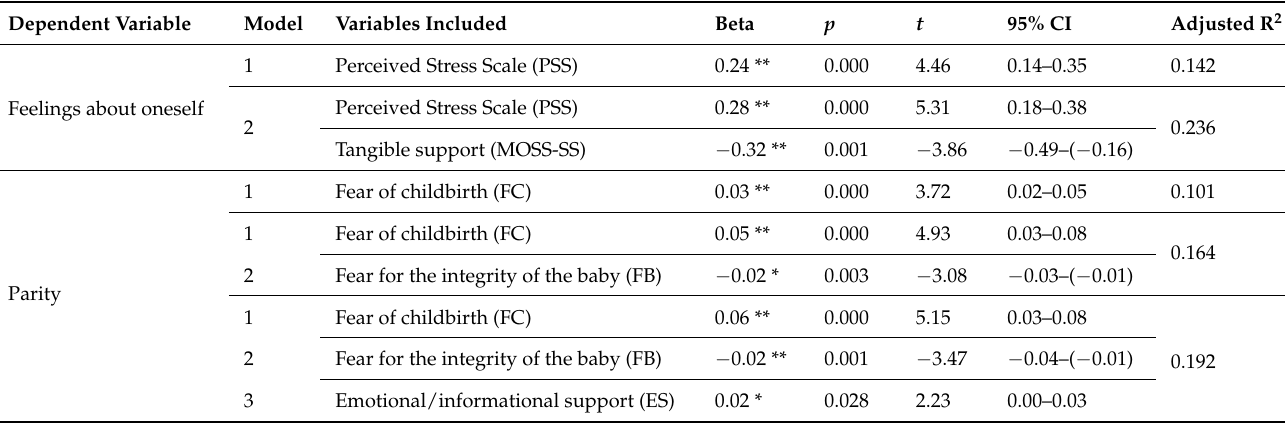
Table 4. Lineal regression